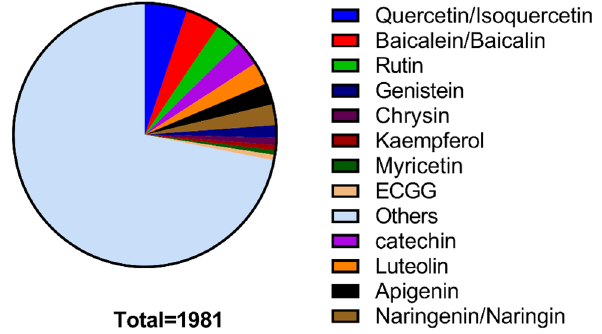
Fig. 2 Literature review on the antiviral activities of natural flavo-